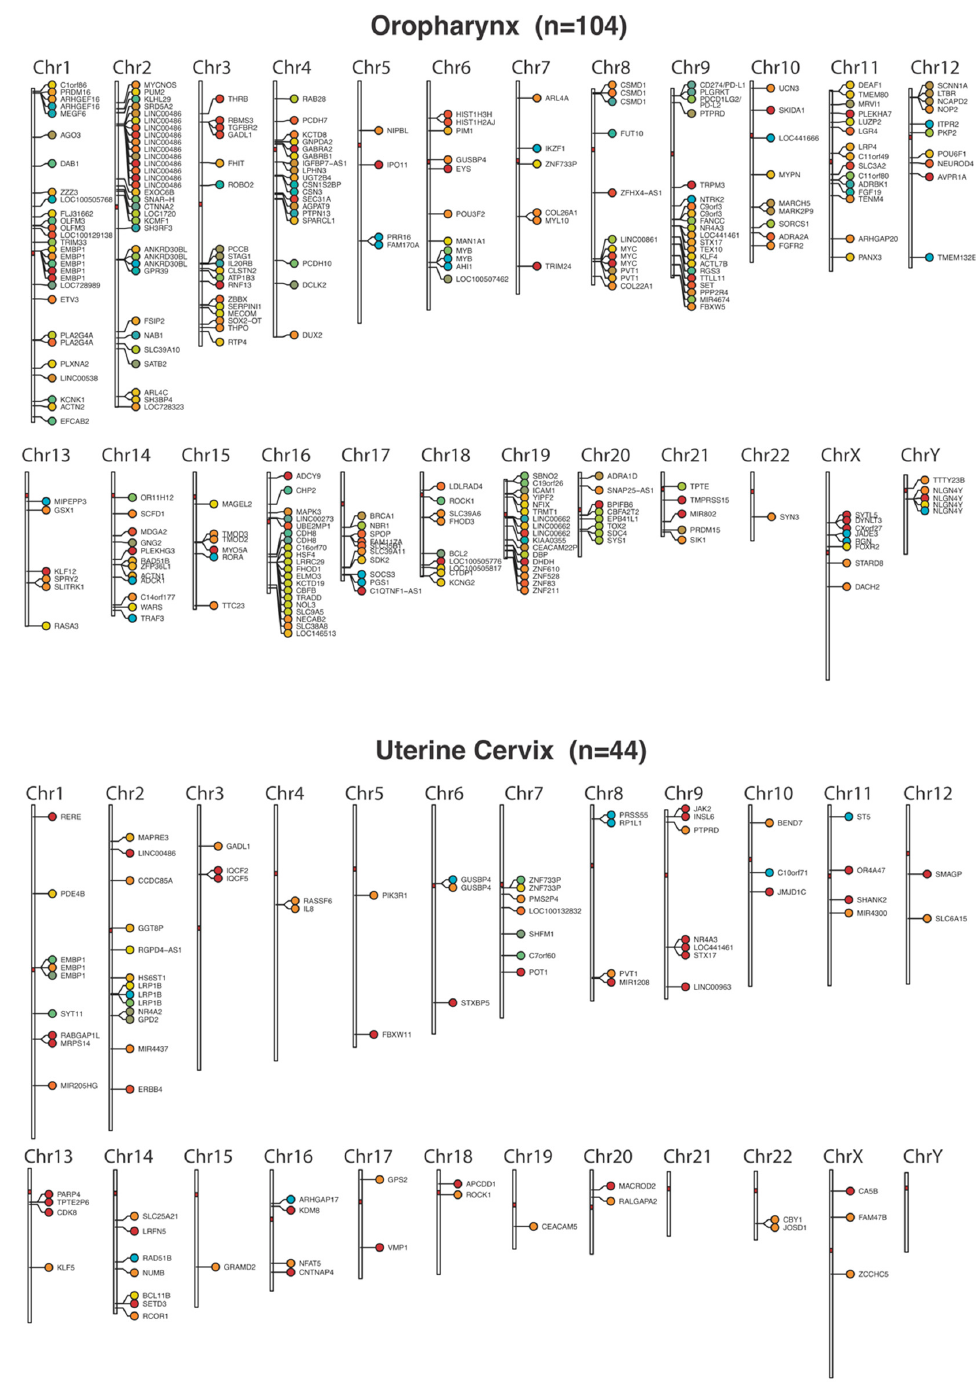
Figure 2. Locations of HPV16 integration sites across the human genome. Genes nearest to the integration sites are indicated. Colors identify tumor samples per chromosome, to allow identification of related sites in single